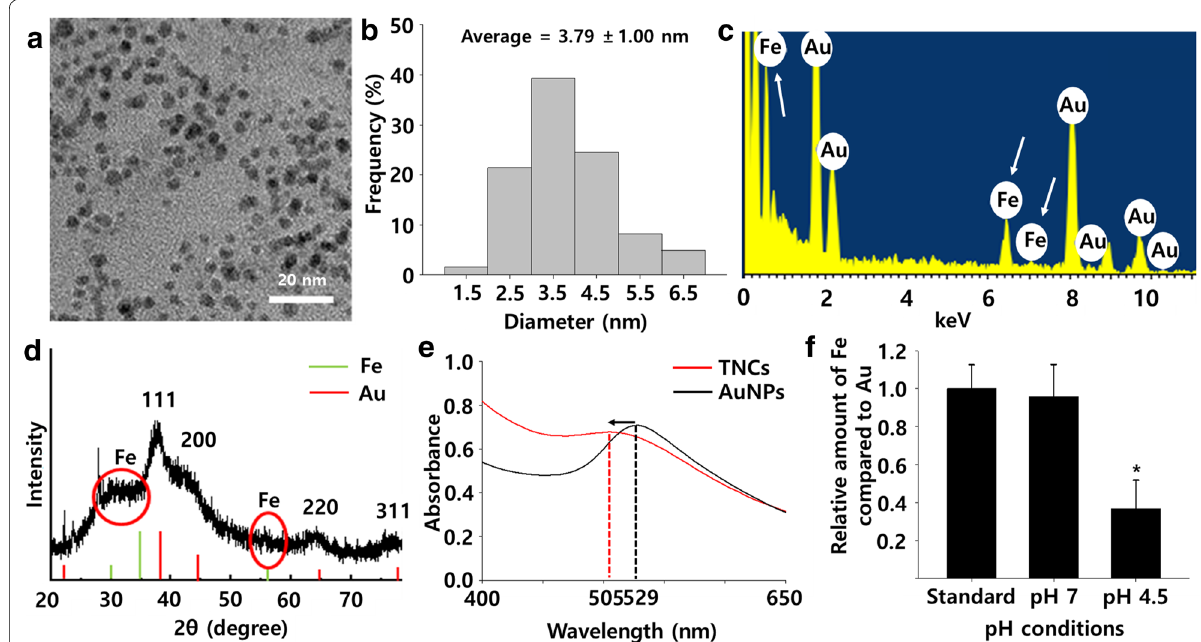
Fig. 2 Characteristics of ps‑TNCs. a TEM image of ps‑TNCs. b Size distribution of ps‑TNCs. The average size of ps‑TNCs is 3.79 1.00 nm. c EDX ± profile of ps‑TNCs. White arrows indicate iron atom peaks. d XRD patterns of ps‑TNCs. Red circles indicate iron ion patterns. e UV–vis spectra of gold nanoparticles (AuNPs, black line) and ps‑TNCs (red line). Peak moves to left side due to the presence of iron. f Atomic ratio (gold/iron) of ps‑TNCs according to the pH difference at 12 h as quantified by EDS. (n 3, * p < 0.05 compared to other =